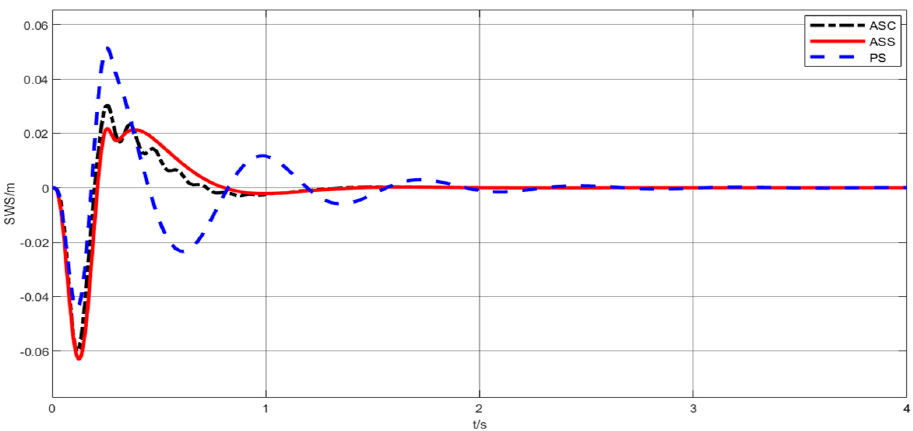
Figure 11. Bump suspension working space responses of different suspensions.